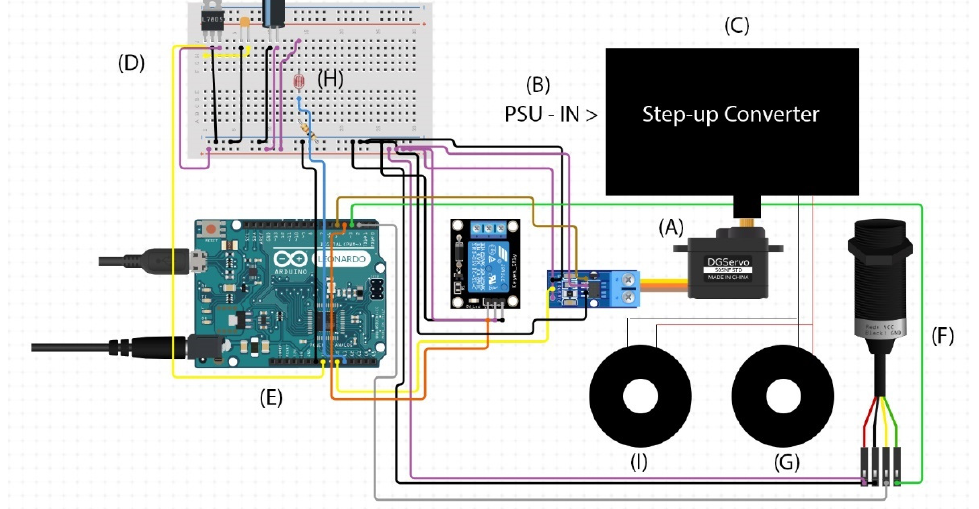
Figure 7. Robotic Eye System Arduino, DEA, FEA Camera, Photo-resistor and PSU Schematic: ( A ) micro servo; ( B ) mains PSU; ( C ) 30 Kv generator; ( D ) Breadboard with a manual control knob; ( E ) Arduino Uno microprocessor; ( F ) GT2005 USB camera; ( G ) right EAP actuator; ( H ) photo-resistor with 200 Ohm resistor; ( I ) left EAP actuator.